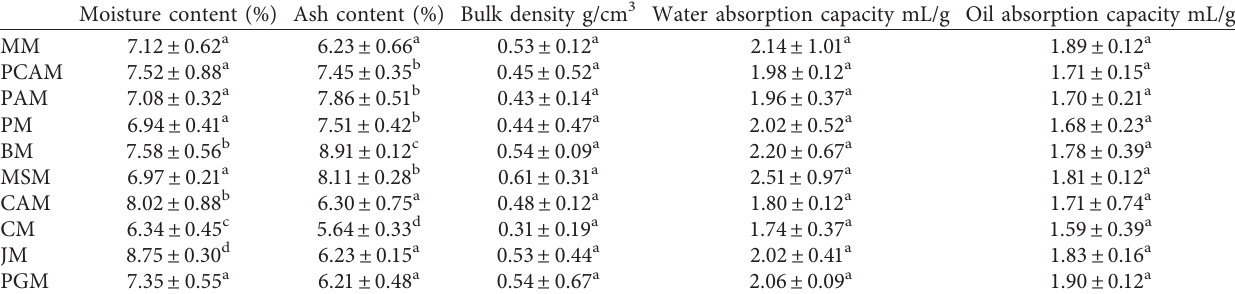
Table 1: Proximate composition and functional properties of SCP from various